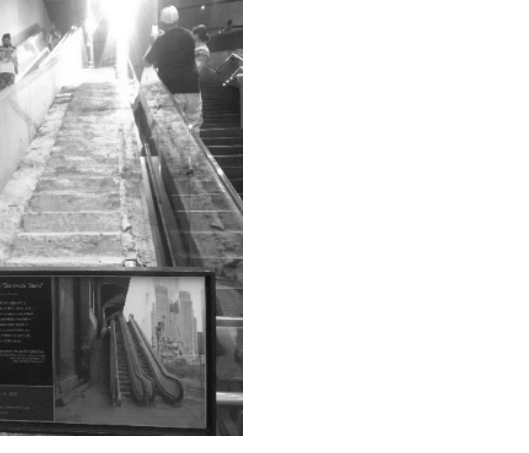
Figure 7. The survival staircase with a reference photo at the 9/11 memorial site.